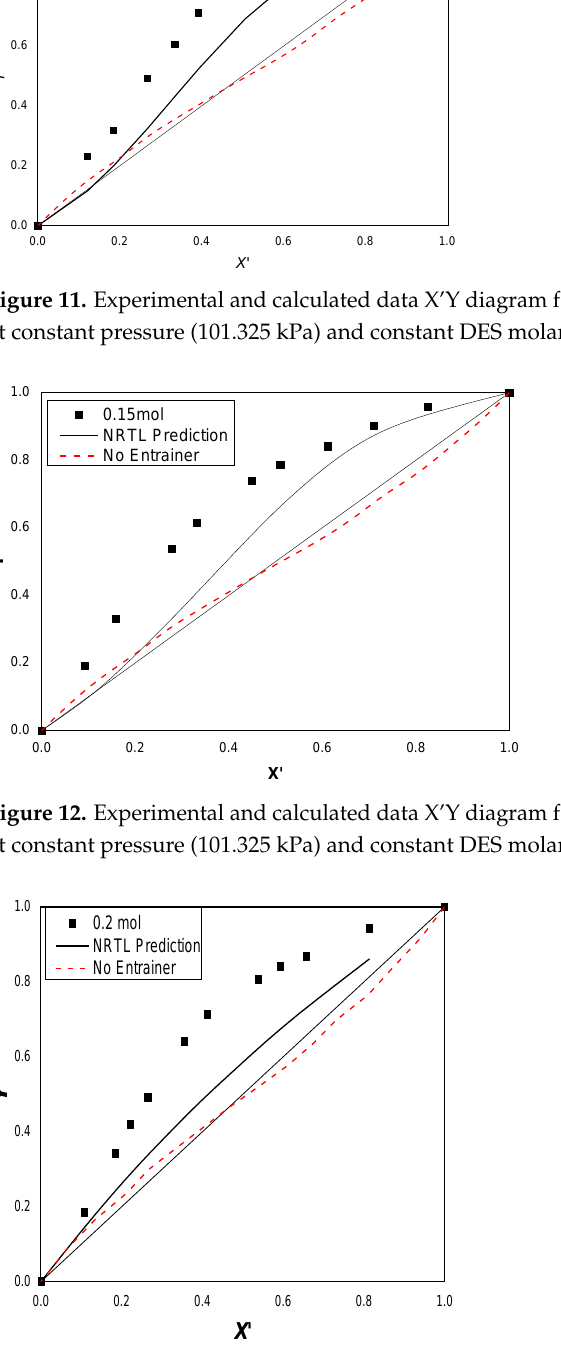
Figure 13. Experimental and calculated data X’Y diagram for cyclohexane (1) + benzene (2) + DES (3) at constant pressure (101.325 kPa) and constant DES molar fraction ( X 3 = 0.2).